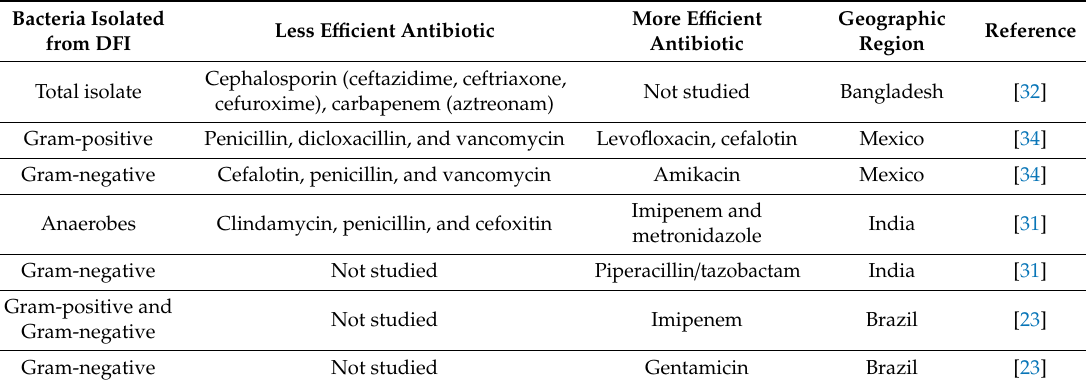
Table 3. Bacteria isolated from diabetic foot infections (DFIs) and their susceptibility to antibiotics by geographic